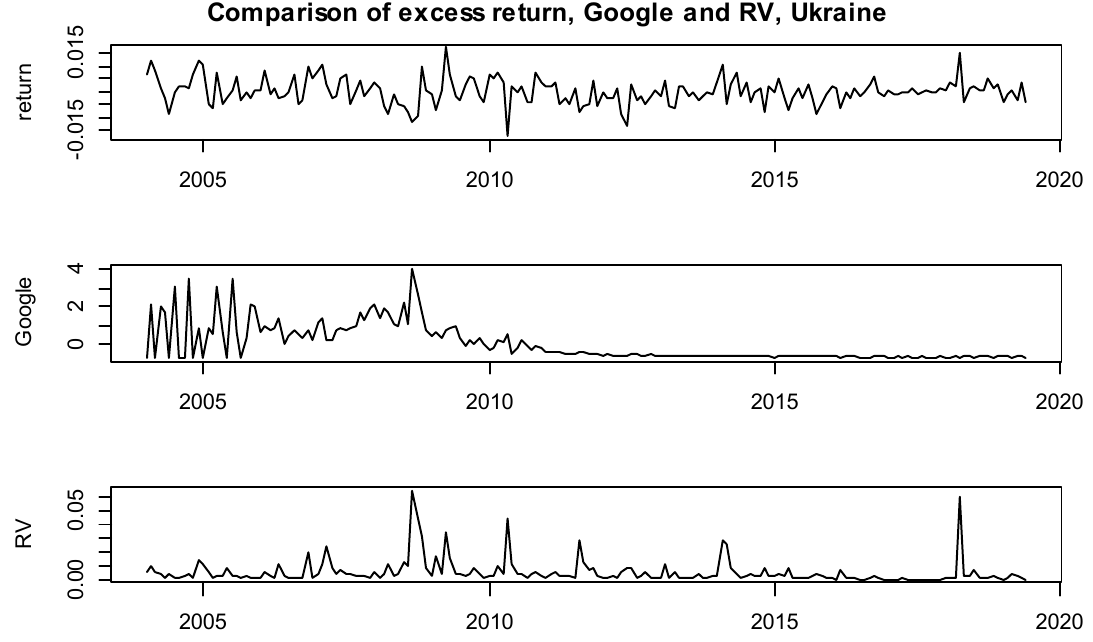
Figure A4. Comparison of monthly series: Excess return, RV and Google search volume, Ukraine.